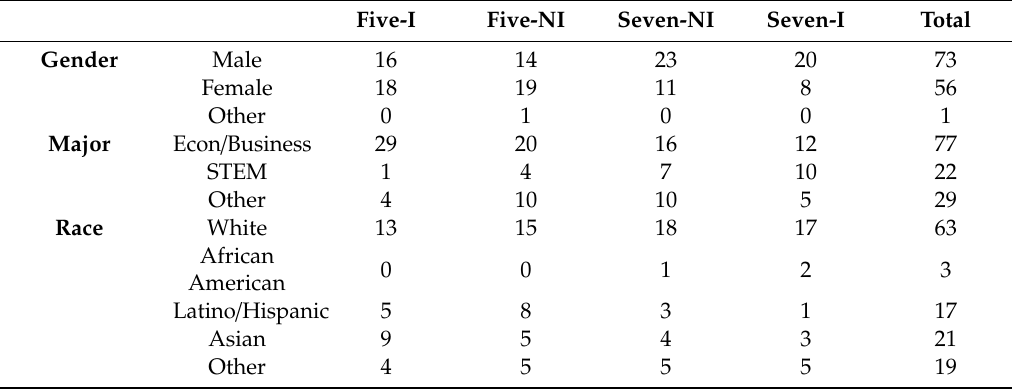
Table A1. A: Demographic information per